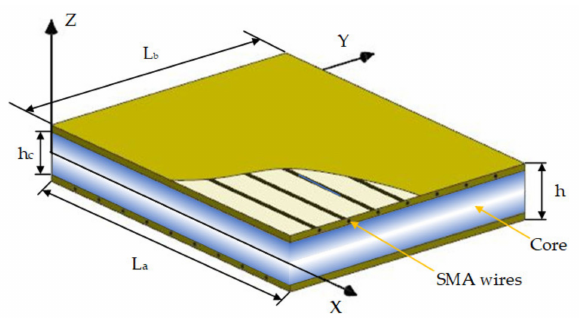
Figure 1. Schematic of a composite sandwich plate with functionally graded core and shape memory alloy (SMA)-composite face